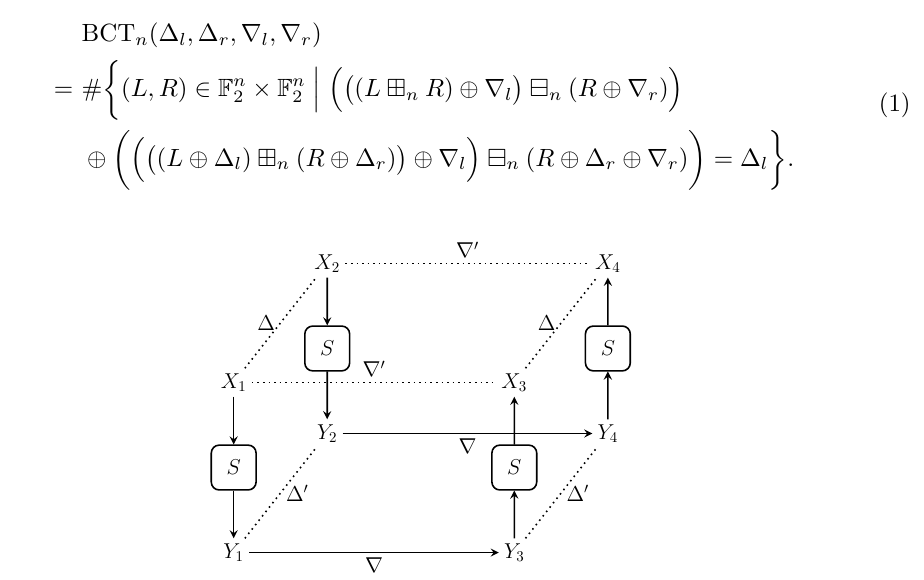
Figure 2: An S-box in the boomerang